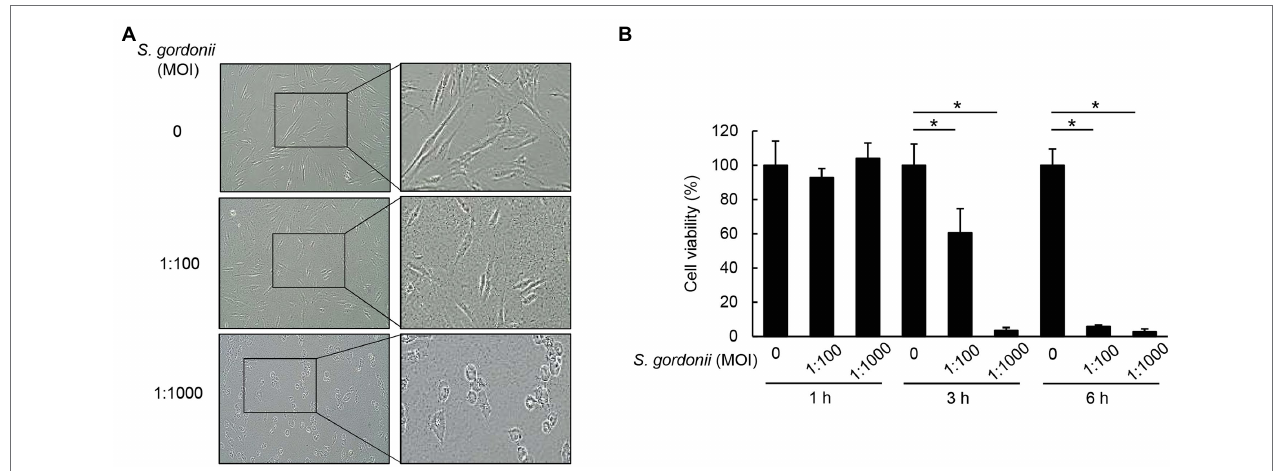
FIGURE 1 | S. gordonii induces cytotoxicity of periodontal ligament (PDL) cells. S. gordonii was cultured to mid-log phase in THY media at 37 ° C. PDL cells were treated with S. gordonii at multiplicities of infection (MOI) 1:10, 1:100, or 1:1,000 for 1, 3, or 6 h. Trypan blue assay was used to determine the number of viable PDL cells. The cells were photographed (A) and counted (B) . One of three similar results is shown. * p <